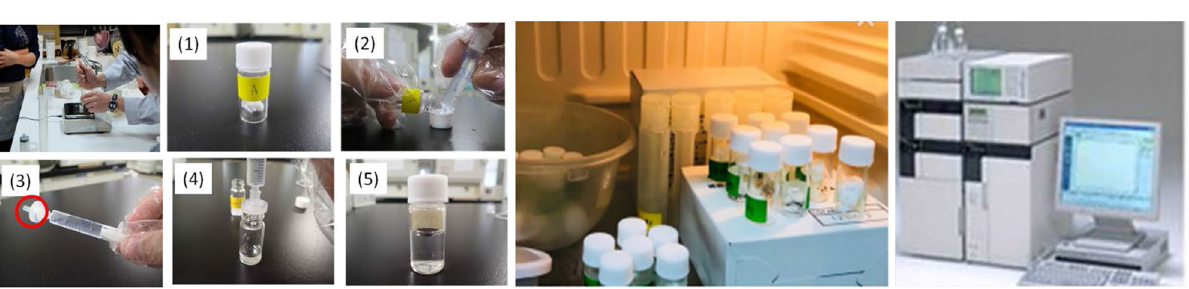
Figure 4. Sample of stain for the culture, NH 3 and Na content